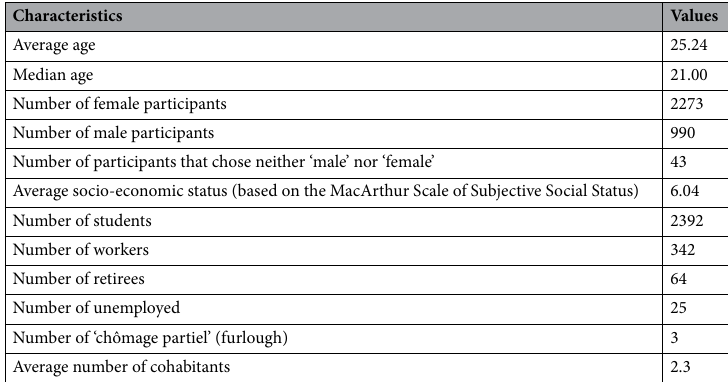
Table 2. Sample characteristics of the 3306 participants having answered all questions.